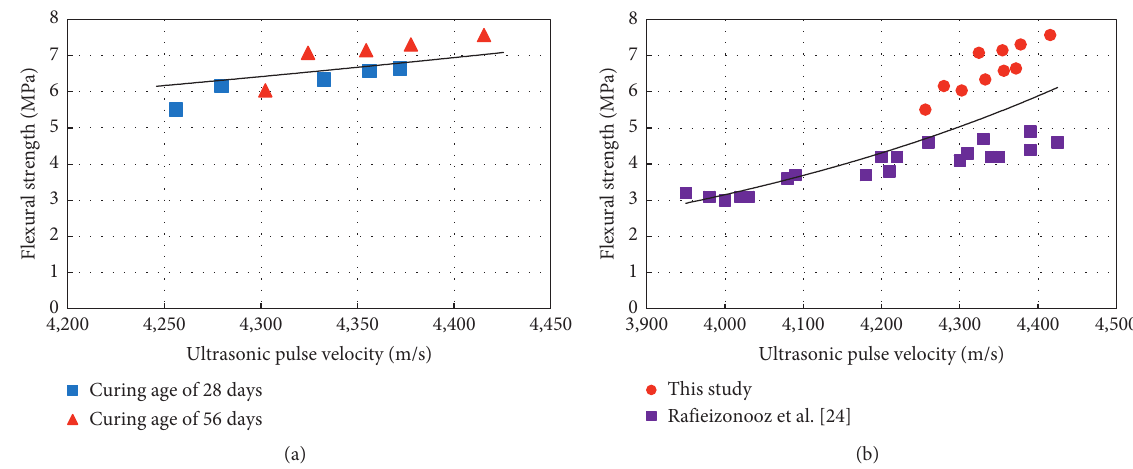
Figure 15: Relationship between the flexural strength and ultrasonic pulse velocity. (a) Test results in this study. (b) Test results in this study and previous